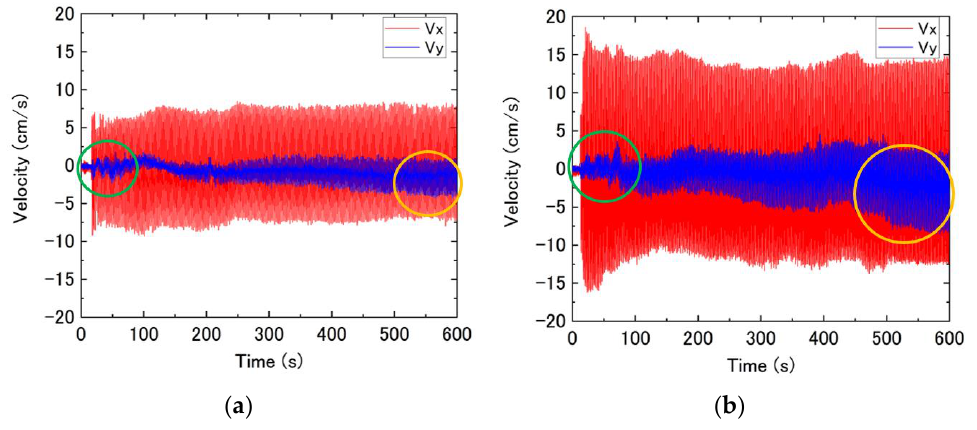
Figure 5. Flow velocity in two different cases: ( a ) Case 2; ( b ) Case 4.